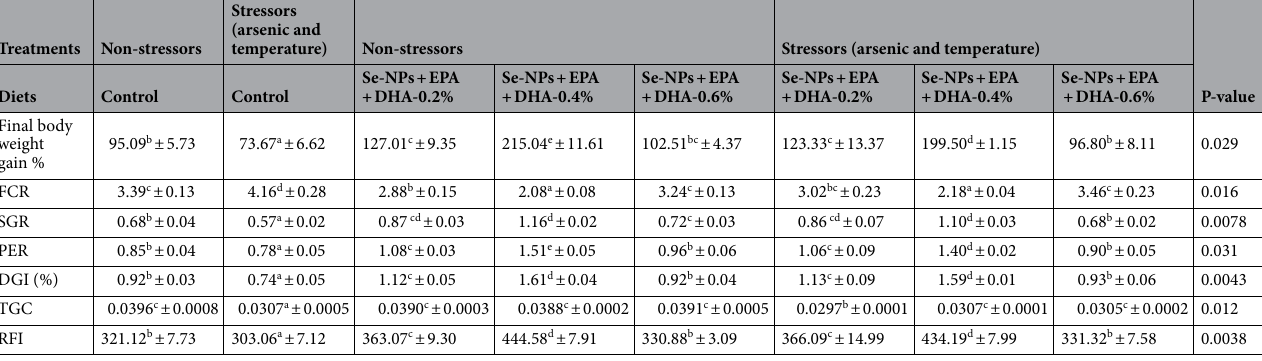
Table 7. Mitigation of tertairy stress response (final body weight gain, FCR, PER, DGI, TGC and RFI) through dietary supplementation of selenium nanoparticles, eicosapentanoic acid and dicosahexanoic acid fed to P. hypophthalmus reared in control or under arsenic and high temperature for 105 days. Values in the same row with different superscript (a, b, c, d, e) differ significantly. Data expressed as Mean ± SE (n = 3). FCR: feed conversion ratio; SGR: specific growth rate; PER: protein efficiency ratio; DGI: Daily growth index; TGC: Thermal growth coefficient; RFI: relative feed